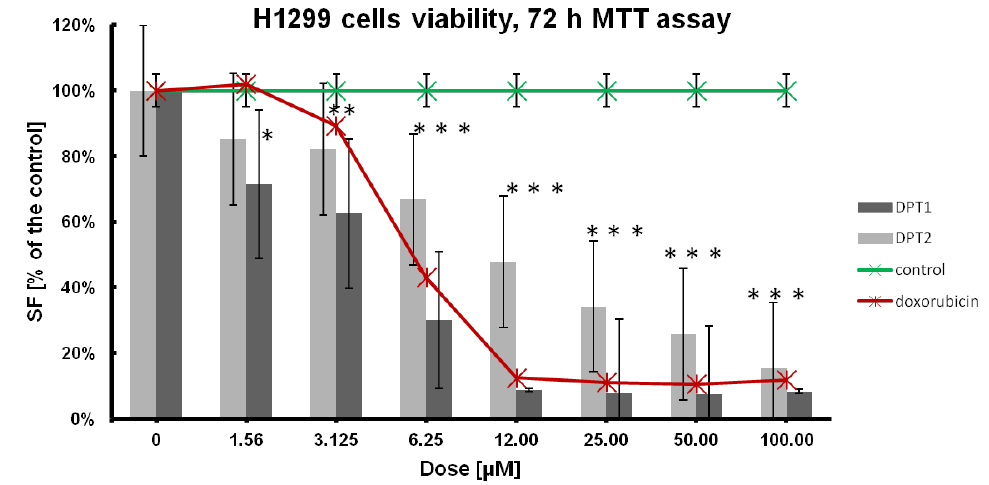
Figure 3. Dose effect of the DPT-1 and DPT-2 treatment on the viability of H1299 cells after 72 h of treatment, followed by MTT assay (control—untreated cells; positive control—doxorubicin-treated cells). Data are presented as mean ± SD. *** or ** or *—statistical significance in comparison to the control was calculated with a t -test, and p -value < 0.05 is indicated with a star.